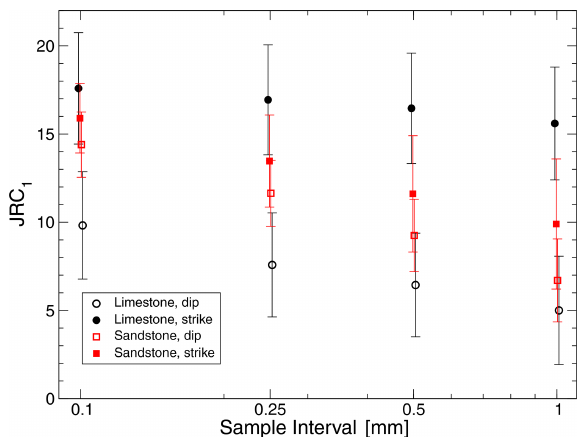
Figure 15. Estimated JRC values calculated based on Eq. (5) for fracture surfaces of the sandstone and limestone specimen. Black: limestone, red: sandstone. Open symbols: profiles taken parallel to shortening direction, filled symbols: profiles perpendicular to short- ening direction. Small horizontal offset between data points in each group added for better visibility of individual error bars.